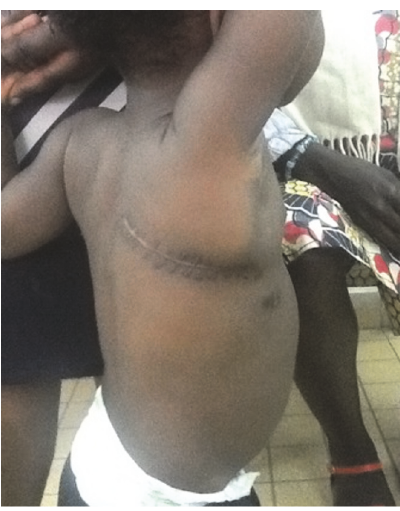
Figure 4: Surgical incision of the posterior thoracotomy in the baby boy one month after the surgery.